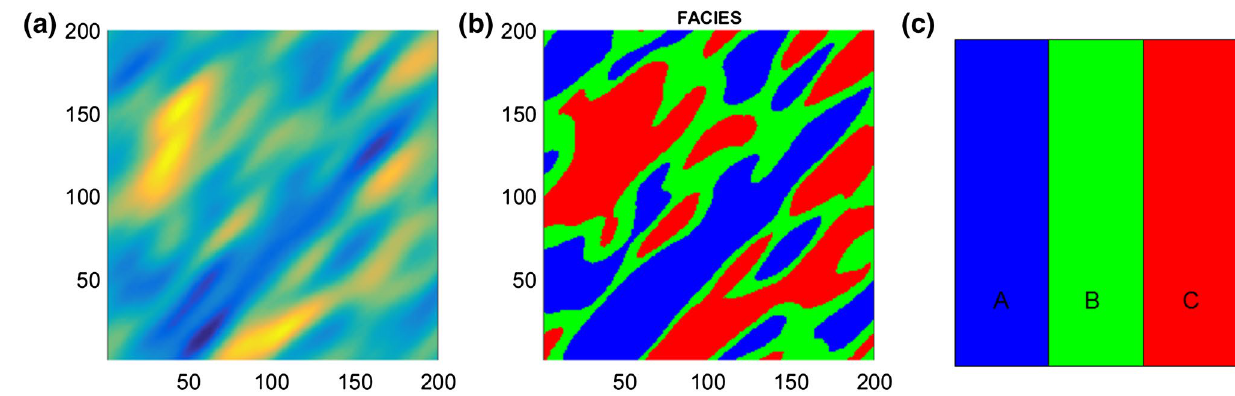
Fig. 2 Truncated Gaussian simulation with a the realization of a Gaussian random function; b the resulting facies realization after applying trun- cation; c the threshold mask